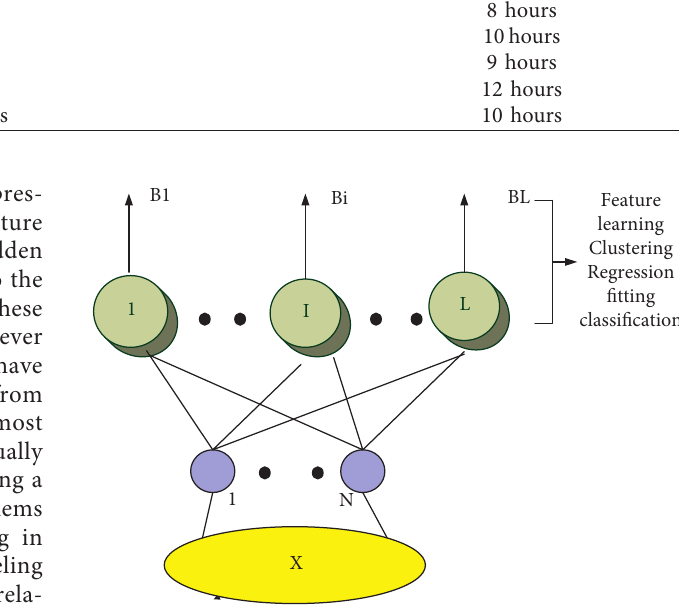
Figure 1: Simple structure and application of overlimit learning